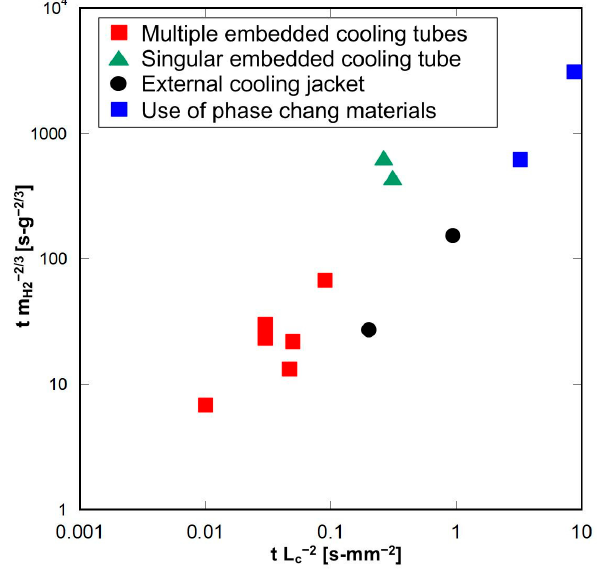
Figure 8. The stored hydrogen mass-based time vs. the characteristic length-based time.